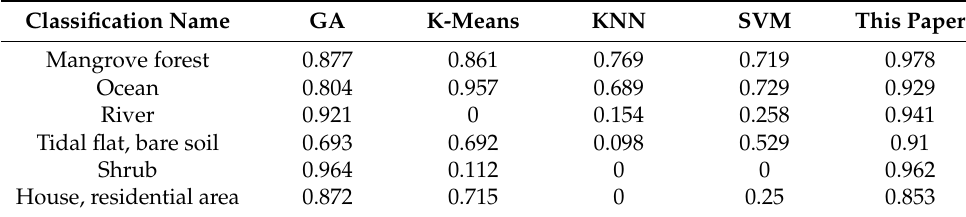
Table 3. Test Results for Accuracy (P) Parameter (Data